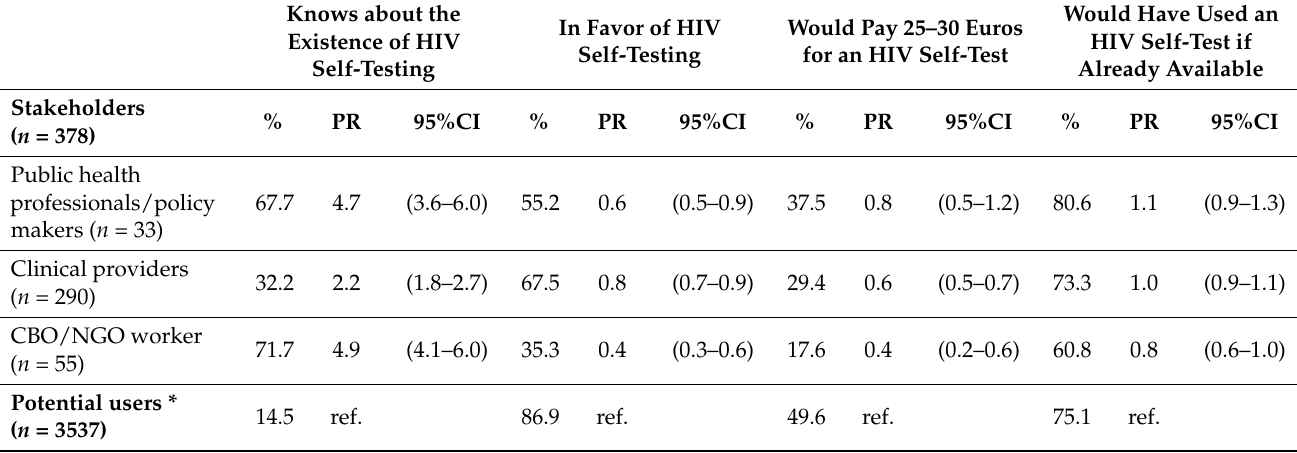
Table 2. Stakeholders’ knowledge, opinion, intention to pay and potential use of HIV self-testing compared to that of potential